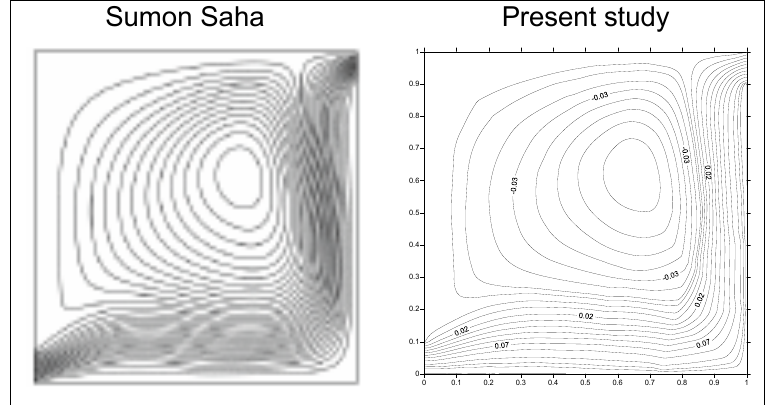
Figure 3 . Comparison of streamlines with the results of Sumon Saha